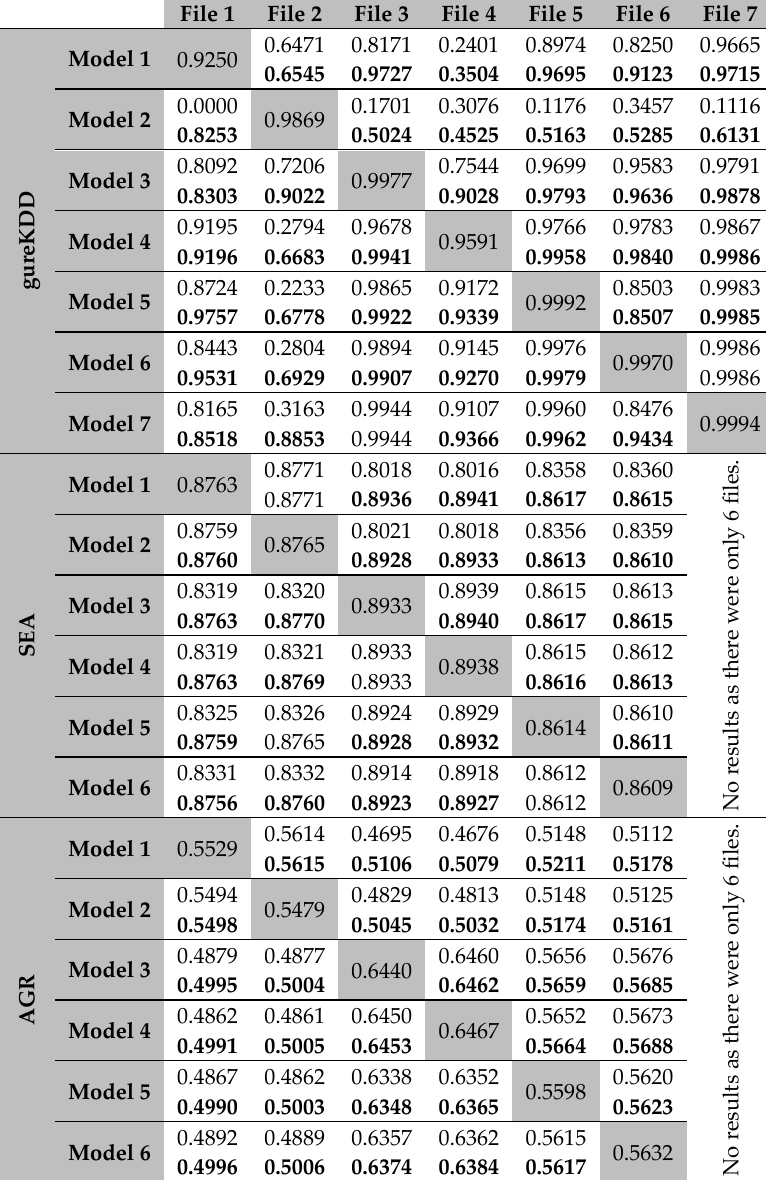
Table A3. SVM model’s performance on di ff erent datasets with various e ff ects (before and after Table 3. SVM model’s performance on different datasets with various effects (before and after threshold adaptation). threshold